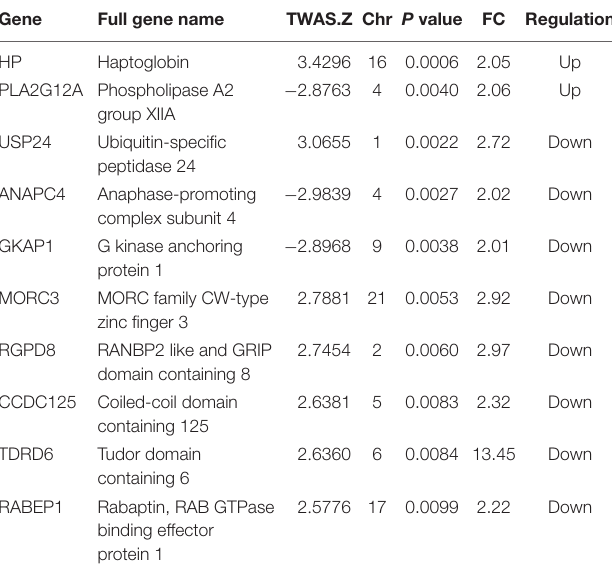
TABLE 2 | Common genes detected by both transcriptome-wide association study (TWAS) and mRNA expression profiles of bone marrow mesenchymal stem